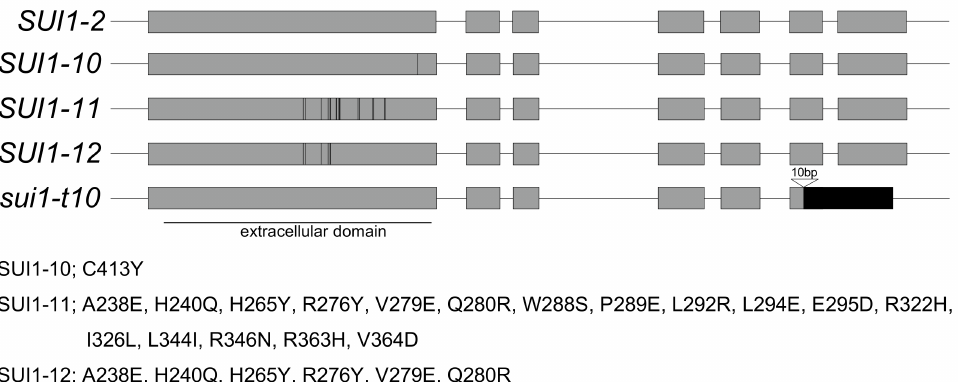
Figure 1. Schematic representation of the SUI1 genomic sequences in this study. The shaded boxes represent the protein coding regions. Positions of amino acid substitutions compared to SUI1-2 are shown by bars and listed below. The extracellular domain (consisting of most of the 1st exon) is indicated. The position of the 10-bp deletion of sui1-t10 is shown in the sixth exon.